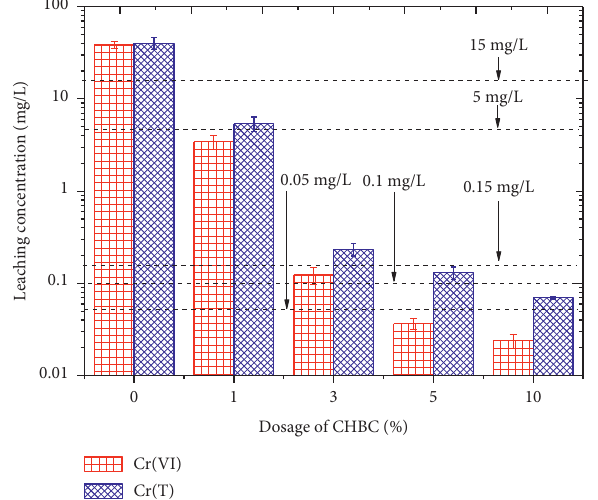
Figure 5: Effect of CHBC dosage on leachability of Cr and Cr(VI) of stabilized soils.